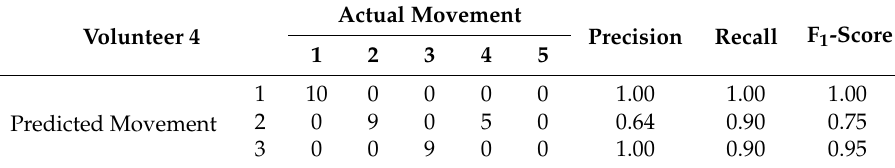
Table A4. Results Volunteer 4.